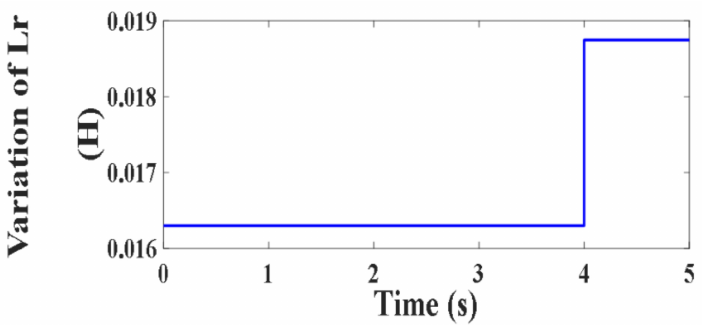
Figure 162. Variation of L r (H).